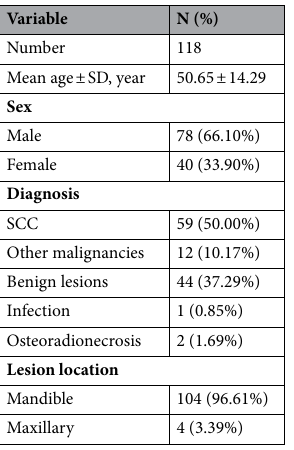
Table 1. The demographic and clinical data of the enrolled